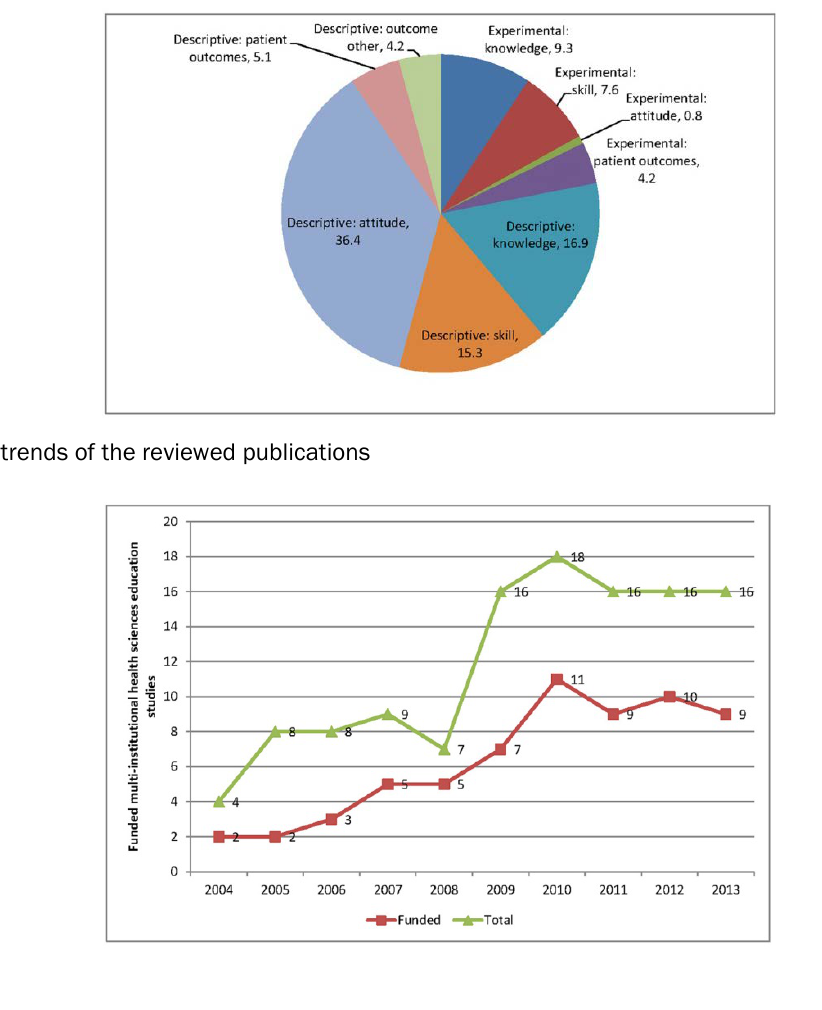
Figure 2 Distribution of study type and outcome measures of the reviewed publications (%)